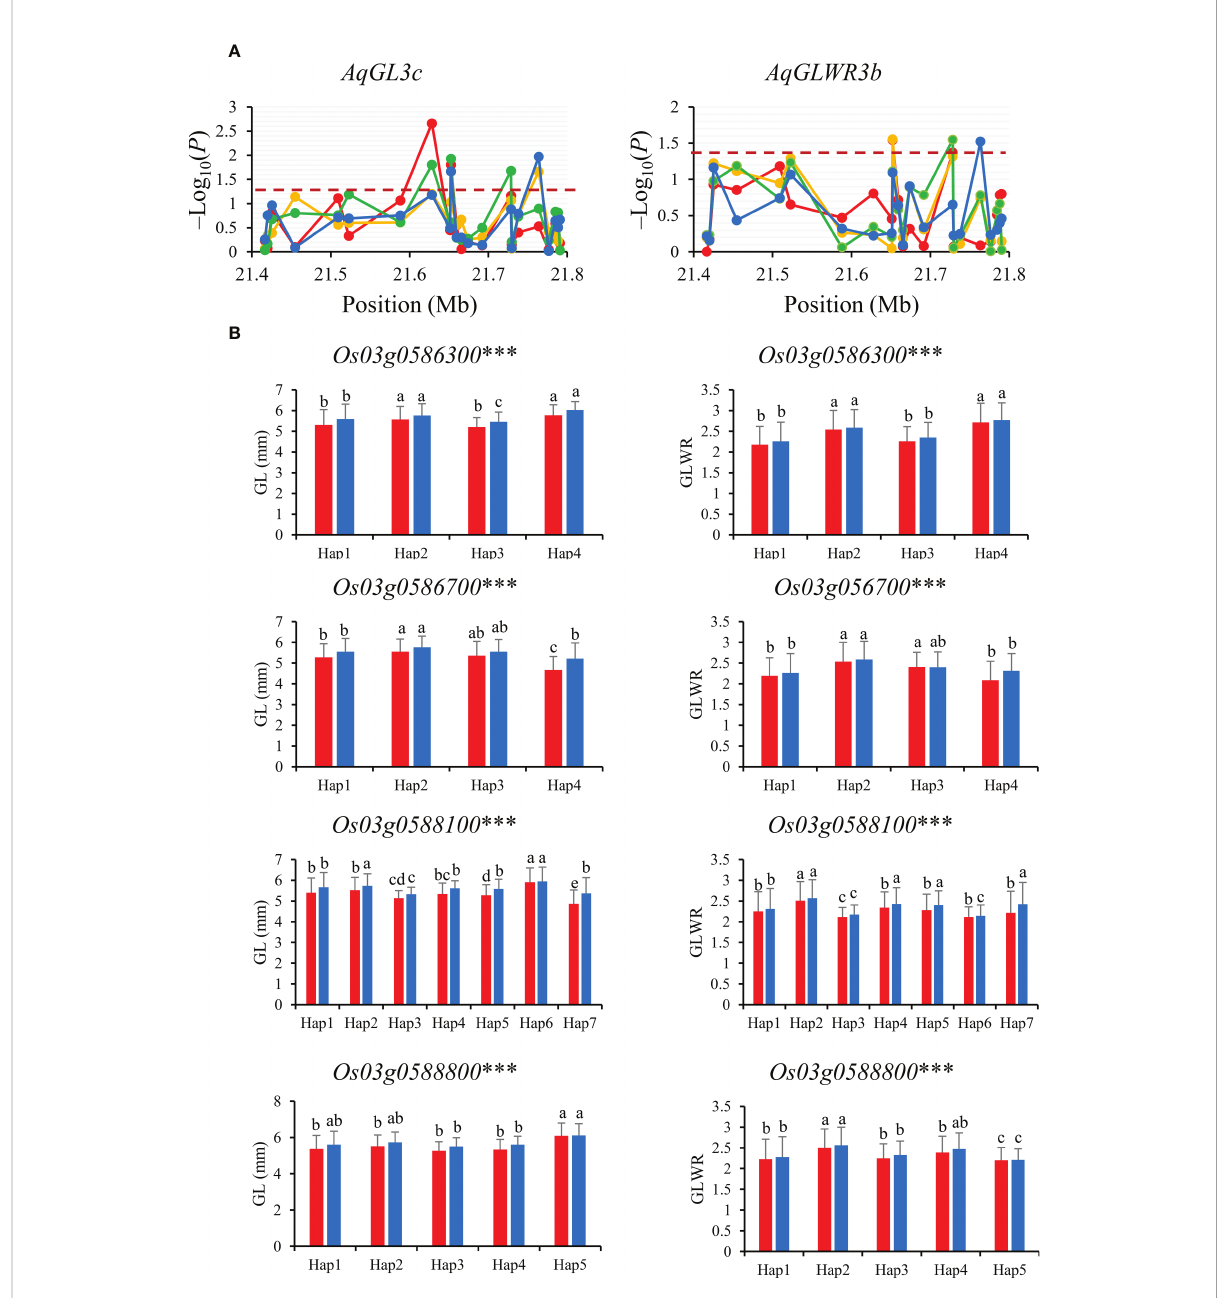
FIGURE 4 Gene-based association analysis (A) and haplotypes analysis of candidate genes (B) of AqGL3c/AqGLWR3b. Dash line showed the threshold to determine signi fi cant SNP. The *** suggested signi fi cance of ANOVA at p < 0.001. The letter on histogram (A – E) indicated multiple comparisons result at the signi fi cant level 0.05. Red, orange, green and blue color of lines indicated 15_PX, 16_PX, 15_SZ and 16_SZ environments, respectively. The red and blue color of the histogram indicated SY and SZ in 2015,